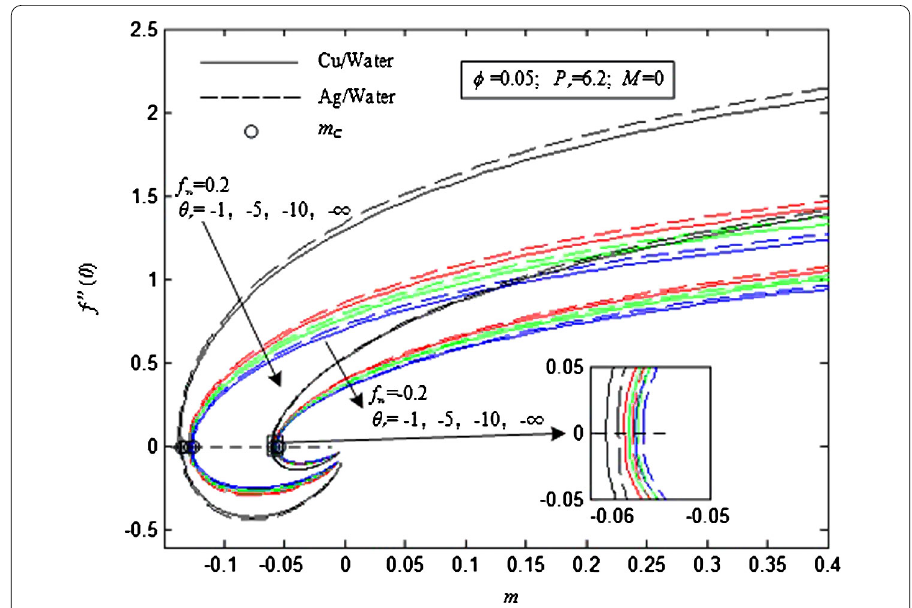
Figure 3 Skin friction coefficient as a function of m for representative values of θ r .